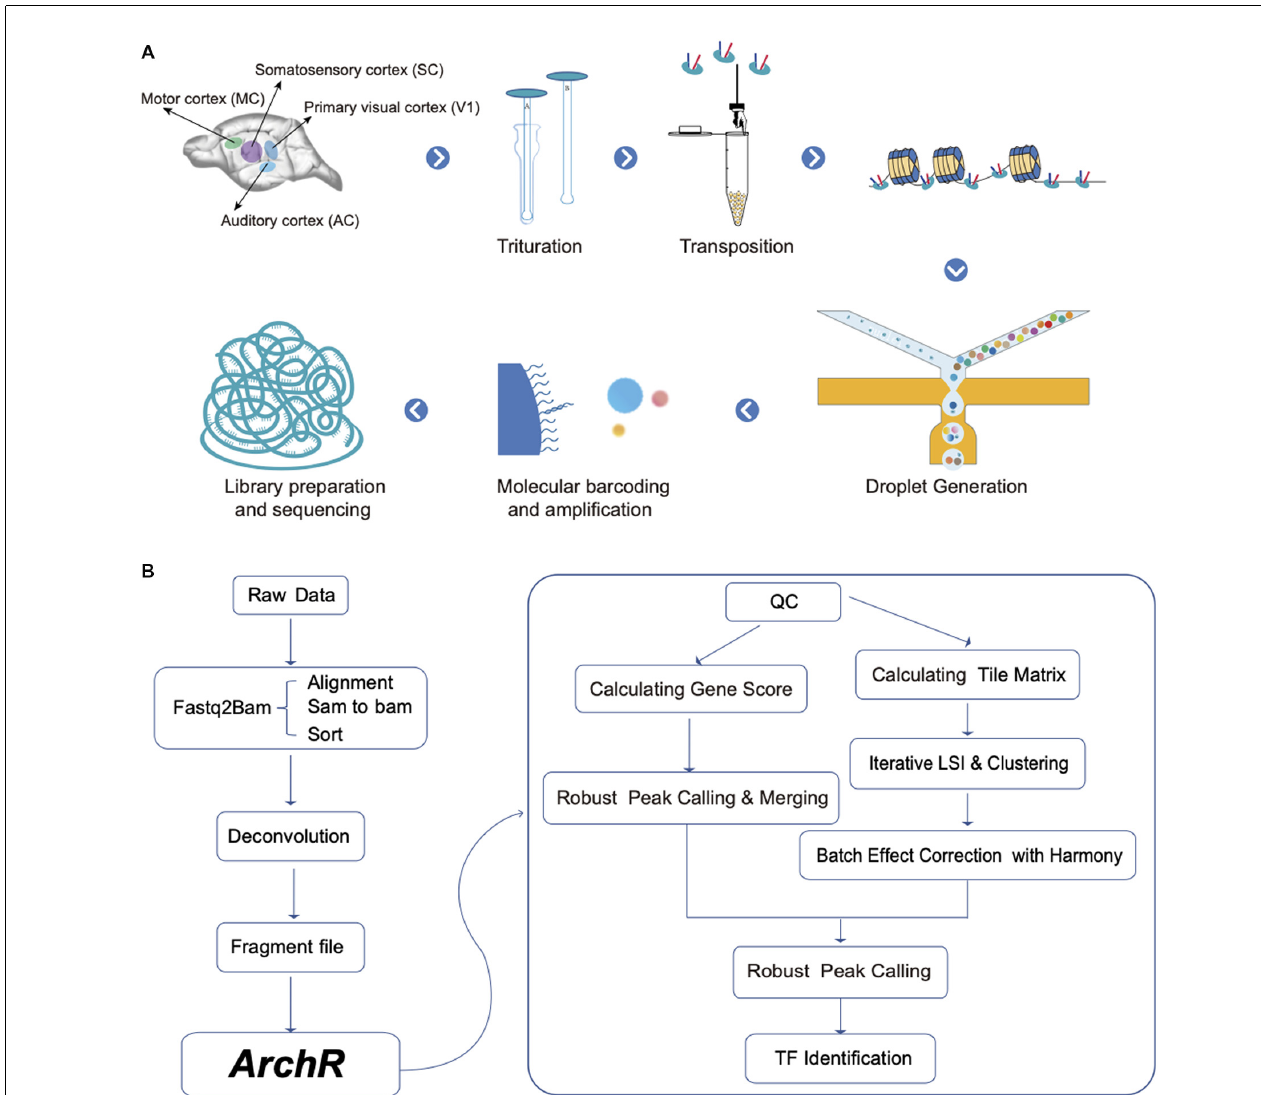
FIGURE 1 | Schematic diagram for experimental and data analysis. (A) A total of four different cortex regions from adult rat brains were collected for single-nucleus assay for transposase-accessible chromatin using sequencing (snATAC-seq) profiling. (B) The analysis workflow for snATAC-seq